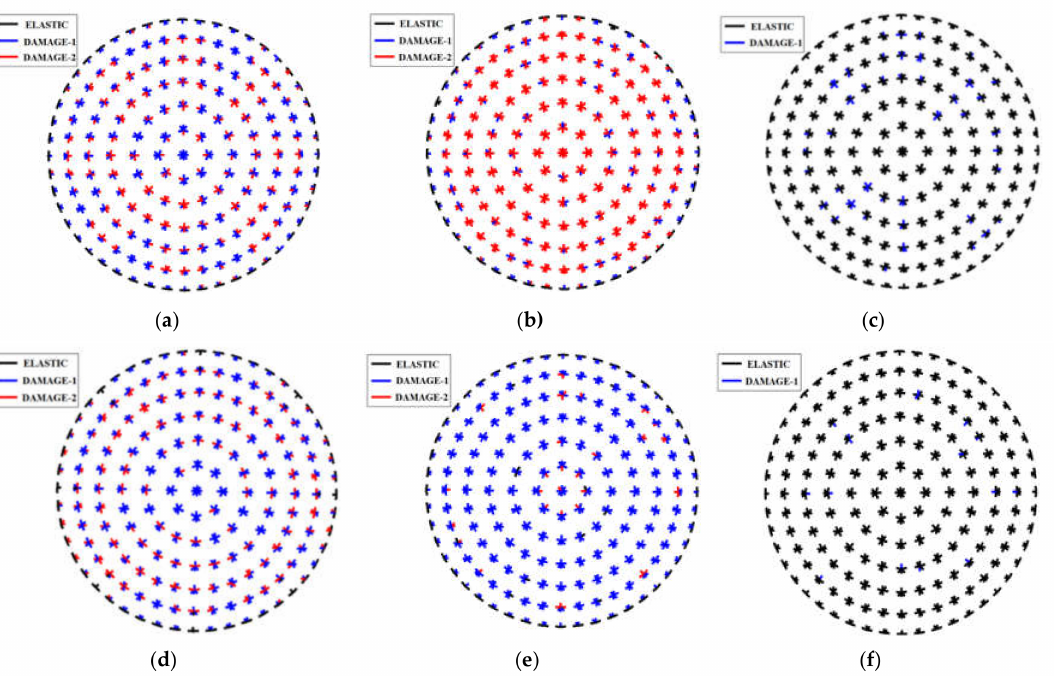
Figure 10. Damage distributions of purlin joints: ( a ) D4053-LSWM axial; ( b ) D4053-LSWM out-of- surface; ( c ) D4053-LSWM in-surface; ( d ) D4053-HHWM axial; ( e ) D4053-HHWM out-of-surface; ( f ) D4053-HHWM